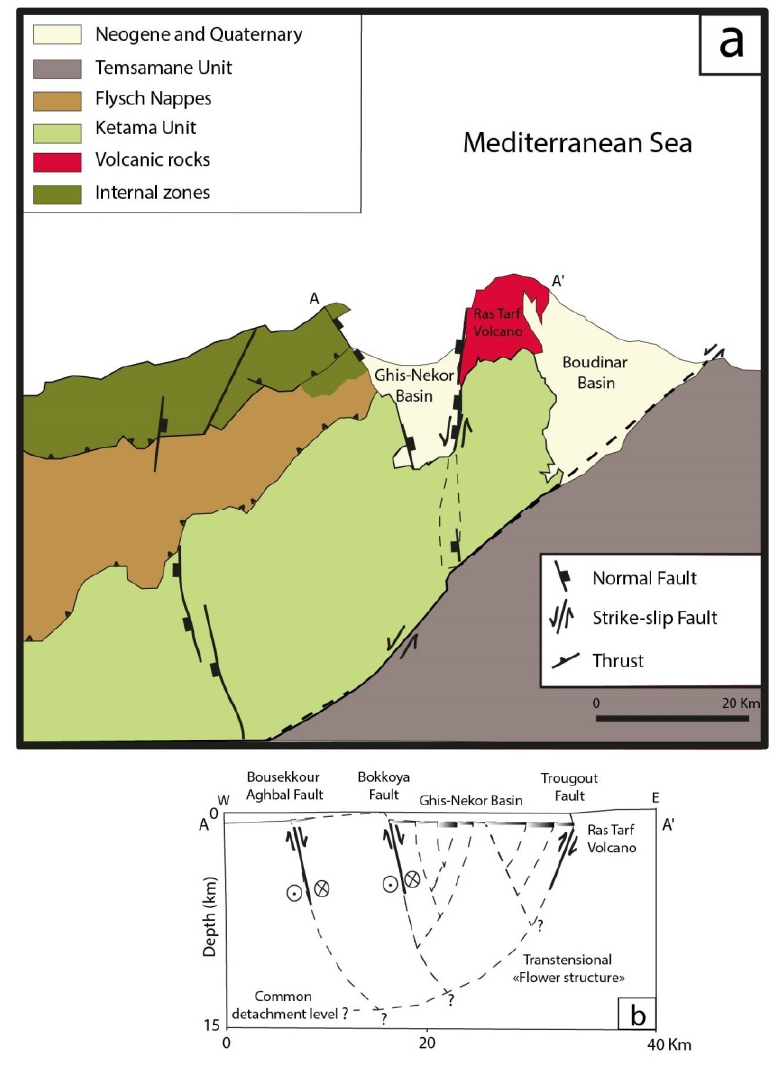
Figure 2. Geological map of the Al Hoceima region ( a ) [ 27–29 ] . E–W structural cross-section AA ′ ( b ) [ 26 ] .